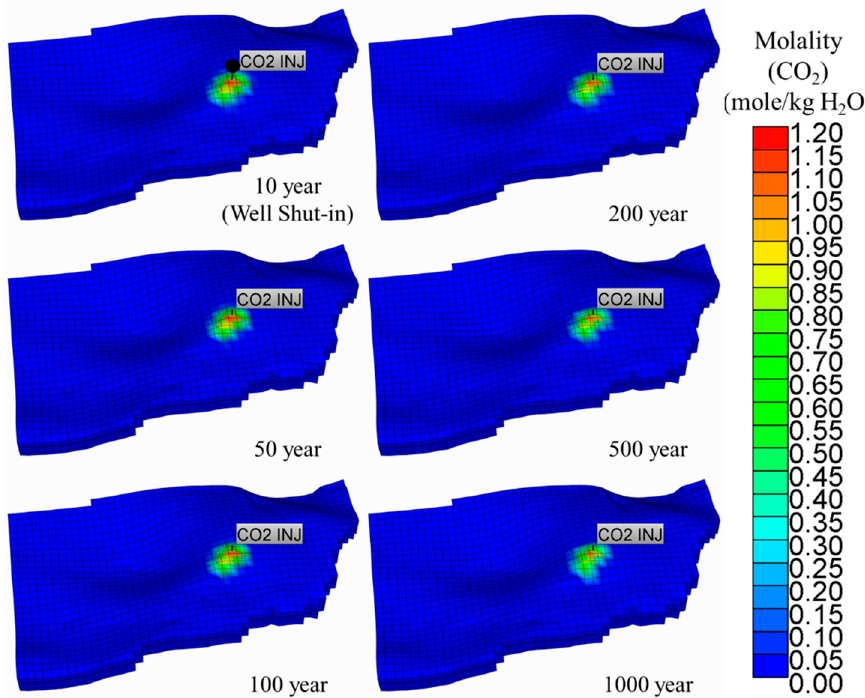
Figure 7. Spatial distribution of the CO 2 molality in the supercritical CO 2 scenario.